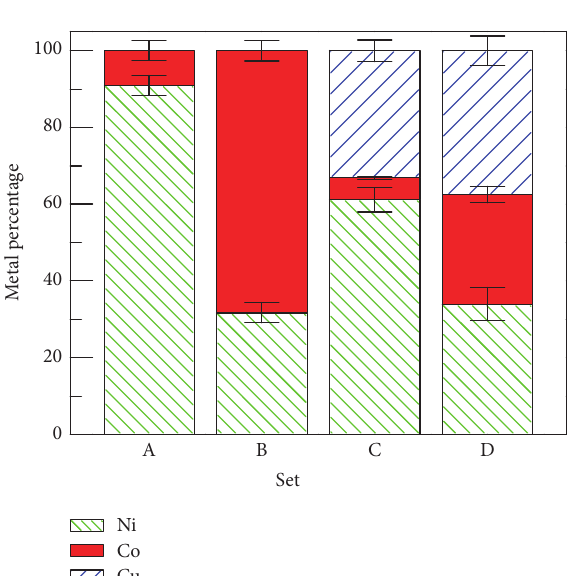
Figure 1: The average as-deposited compositions for all four sets of samples.